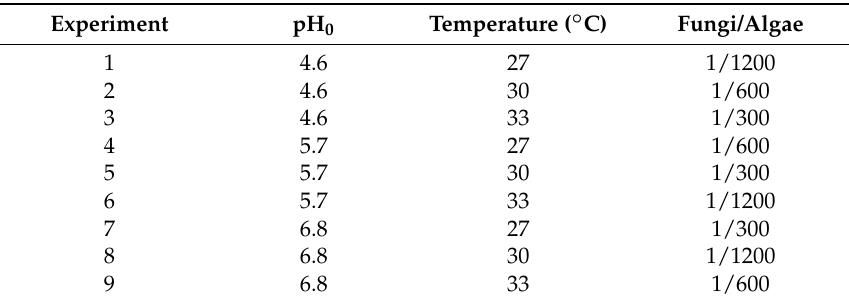
Table 1. Taguchi L 9 Experimental